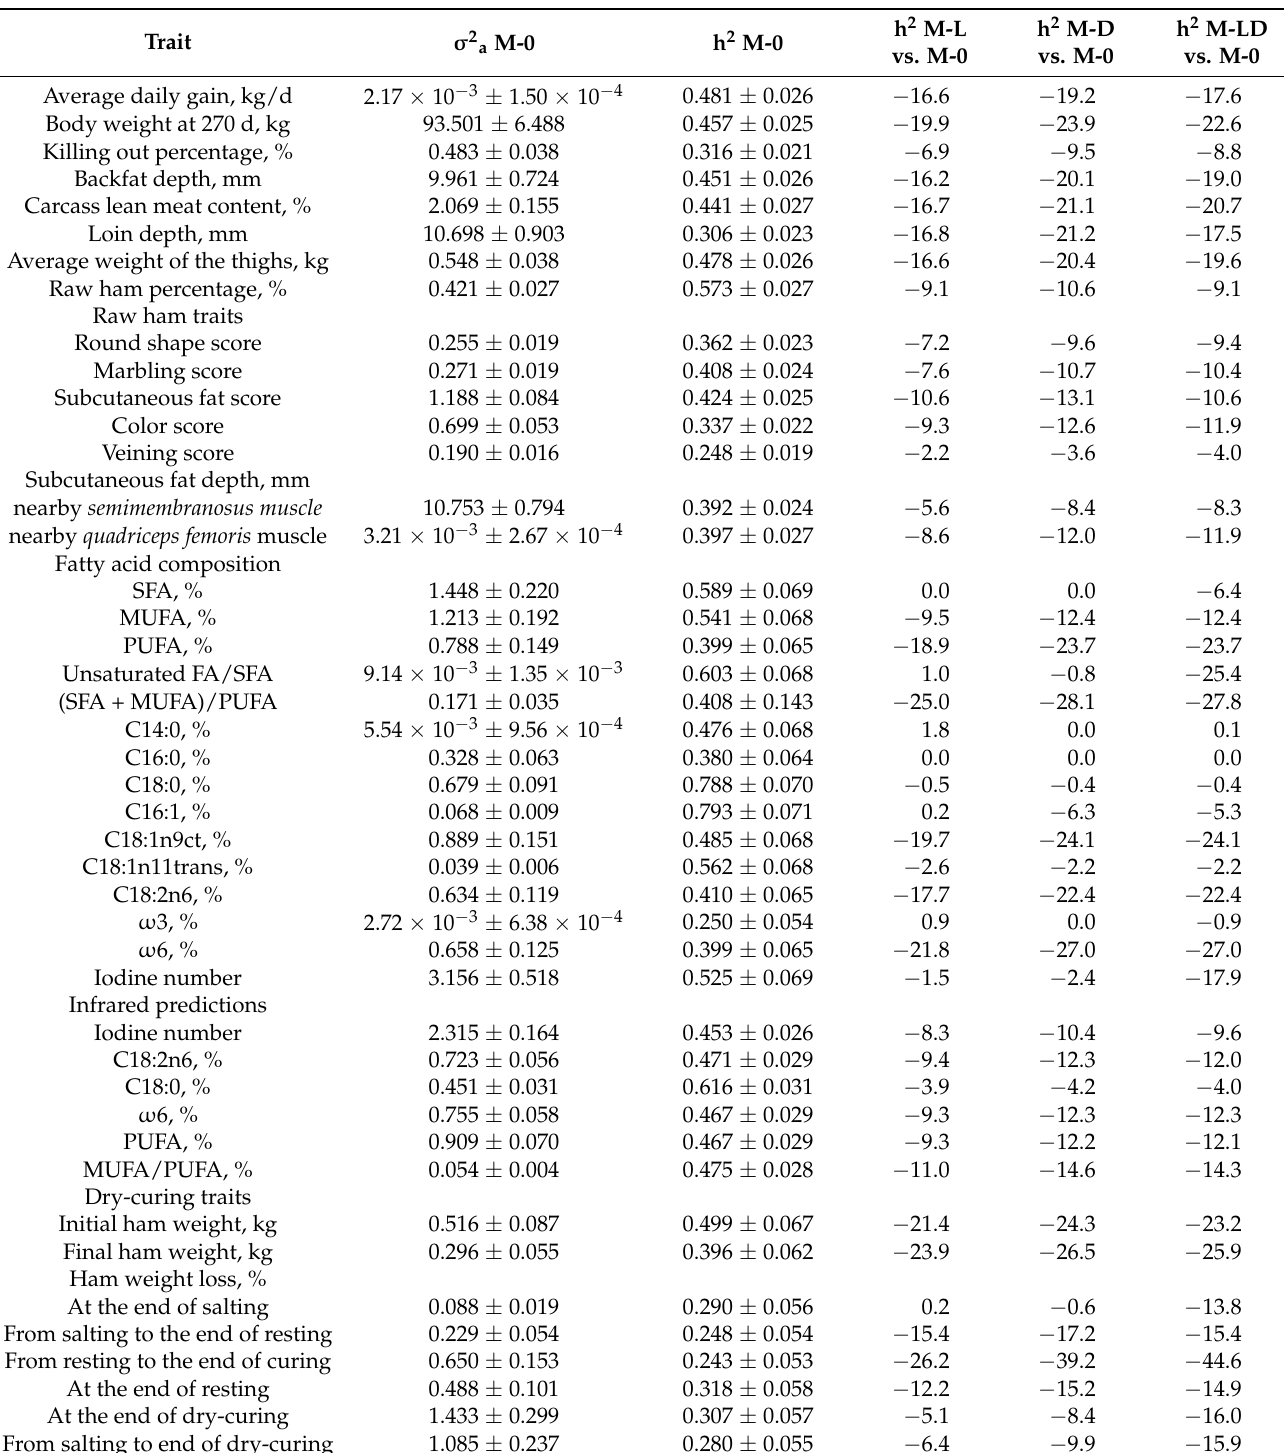
Table 3. Estimates of additive genetic variance ( σ 2 a ) and h 2 ( ± SE) with Model M-0 and variation (%) in h 2 estimates obtained by models M-L, M-D, and M-LD 1